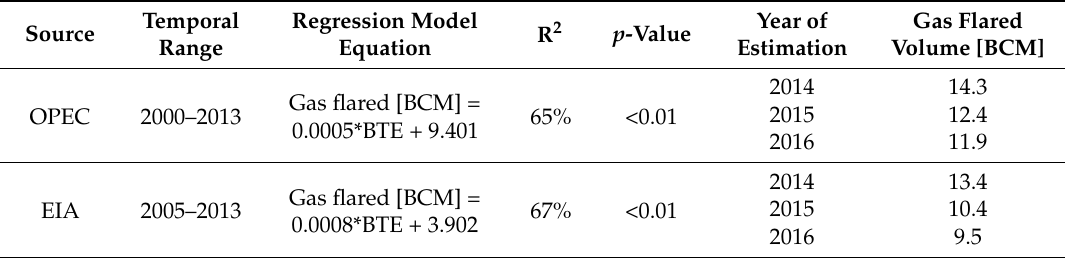
Table 2. Regression models data.